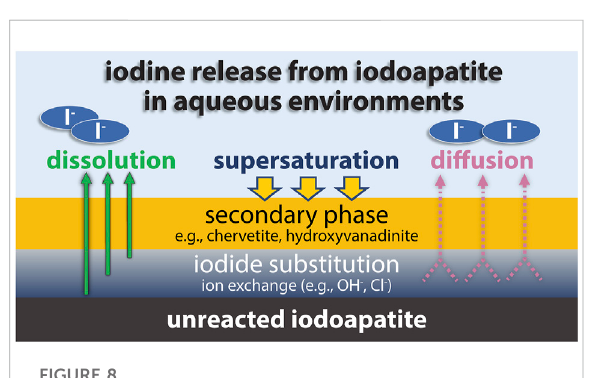
FIGURE 8 Schematic diagram illustrates major processes that